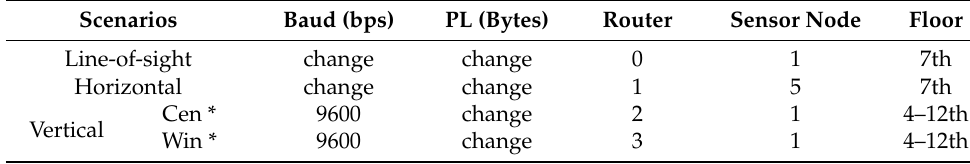
Table 3. Experimental parameters.